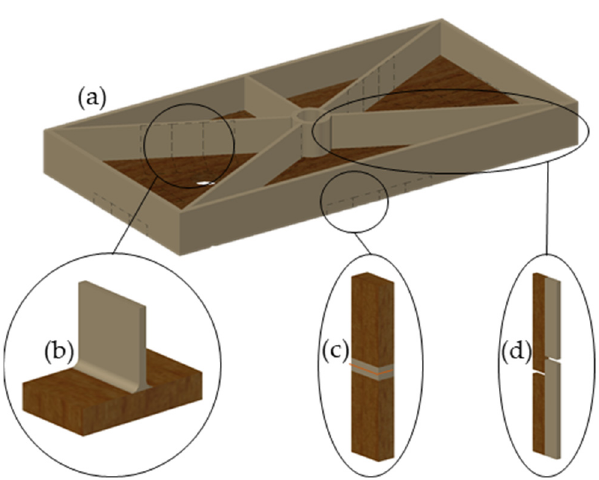
Figure 1. Schematic of the overmolded plywood boards ( a ) and schematic representation of the specimens for the tensile strength perpendicular to the plane of the board σ P ( b ), tensile strength perpendicular to the edge σ E ( c ) and tensile shear strength σ S ( d ).